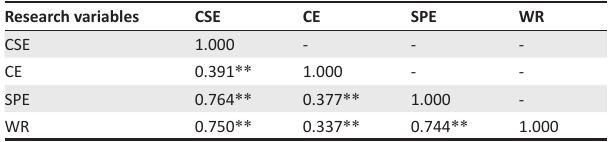
TABLE 3: Correlation matrix.